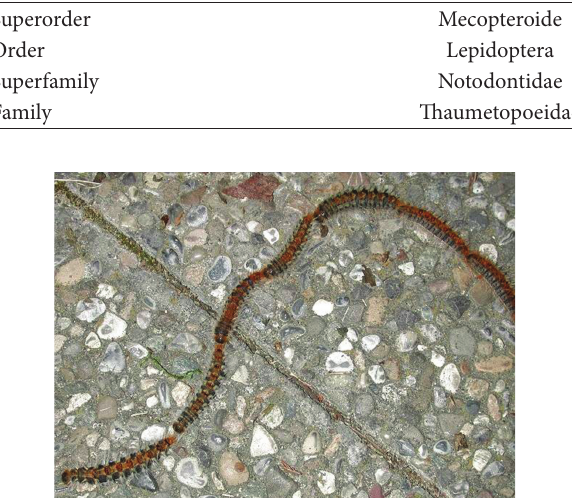
Figure 1: Thaumetopoea pityocampa Schiff larvae in a procession